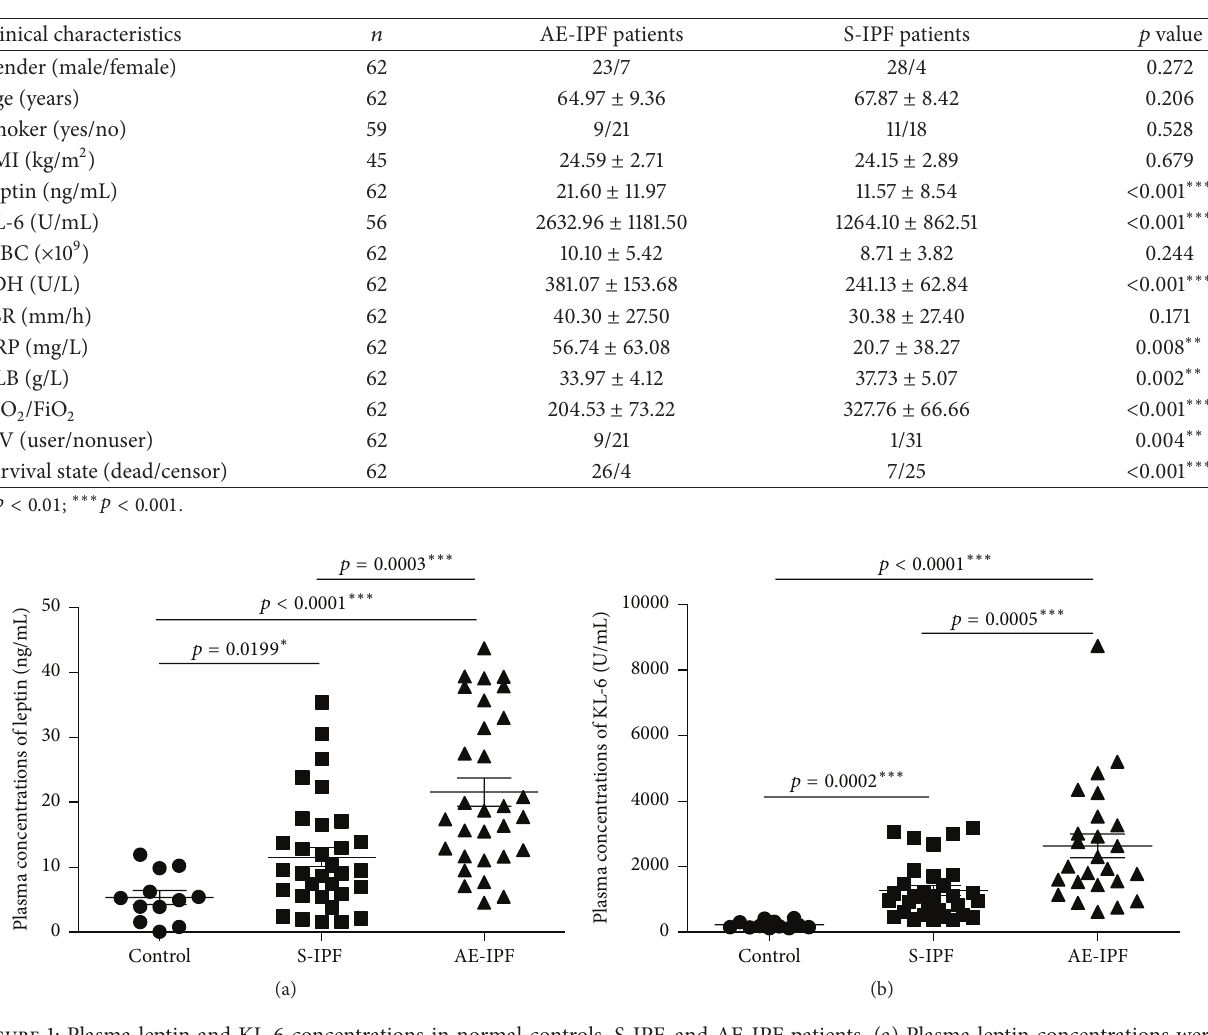
Figure 1: Plasma leptin and KL-6 concentrations in normal controls, S-IPF, and AE-IPF patients. (a) Plasma leptin concentrations were elevated significantly in AE-IPF patients when compared with S-IPF patients and healthy controls by ELISA ( 𝑝 = 0.0003 and 𝑝 < 0.0001 , resp.). Plasma leptin in S-IPF patients was also increased significantly compared with normal controls ( 𝑝 = 0.0199 ). (b) Plasma KL-6 levels were enhanced significantly in AE-IPF patients compared with S-IPF patients and healthy controls ( 𝑝 = 0.0005 and 𝑝 < 0.0001 , resp.). Plasma KL-6 in S-IPF patients was also significantly higher than that in normal controls ( 𝑝 = 0.0002 ). ∗ 𝑝 < 0.05 , ∗∗∗ 𝑝 < 0.001